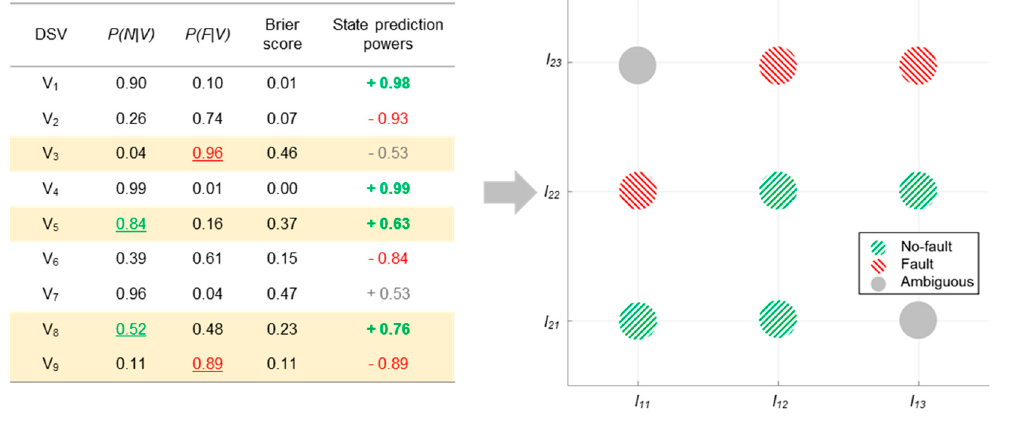
Figure 4. State prediction by state prediction powers.